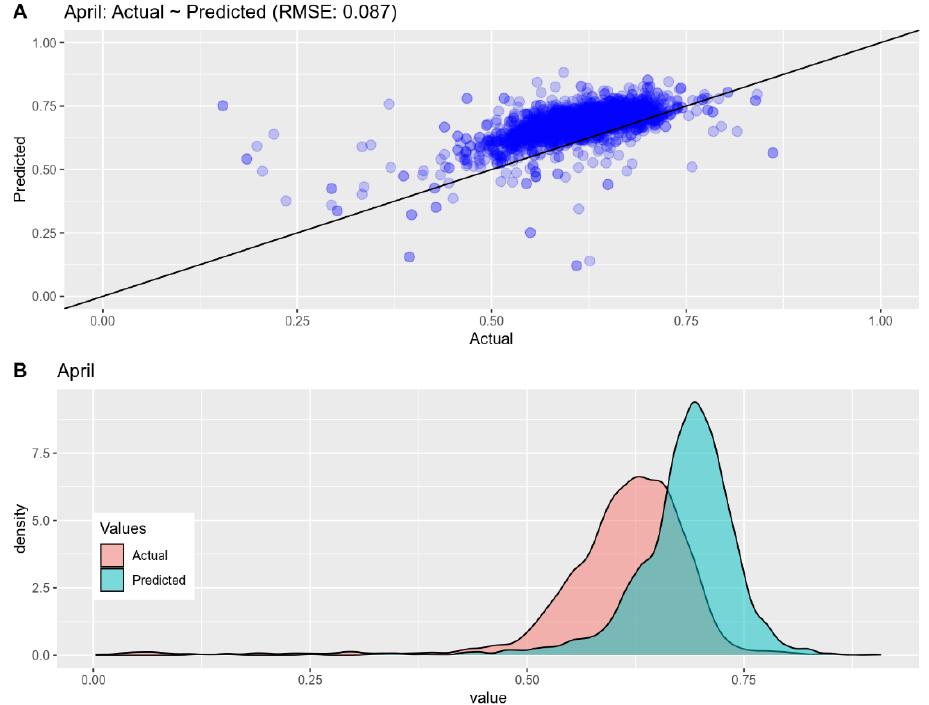
Figure A4. Comparison between actual~predicted for April 2020.